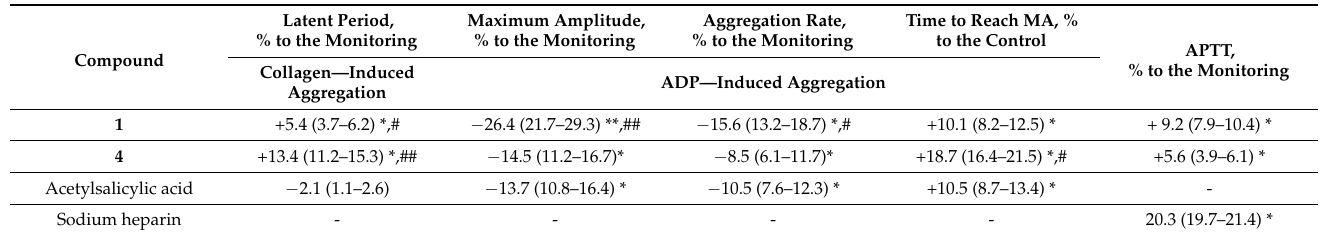
Table 2. Comparison between the effect of compounds 1 , 4 and commercial drugs on platelet aggregation and plasma hemostasis, Me